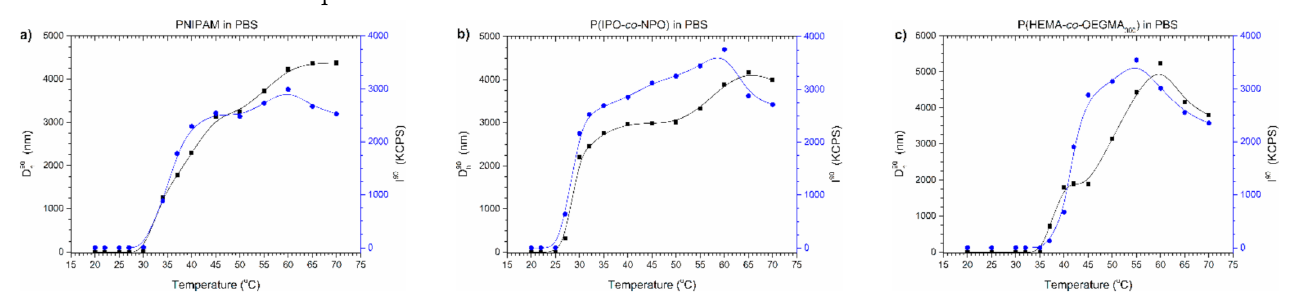
Figure 6. D h90 and I 90 versus temperature plots of solution of ( a ) PNIPAM, ( b ) P(IPO- co -NPO) and ( c ) P(HEMA- co - OEGMA 300 ) in commercial PBS. Polymer concentration: 0.5 g/L; gradual heating.